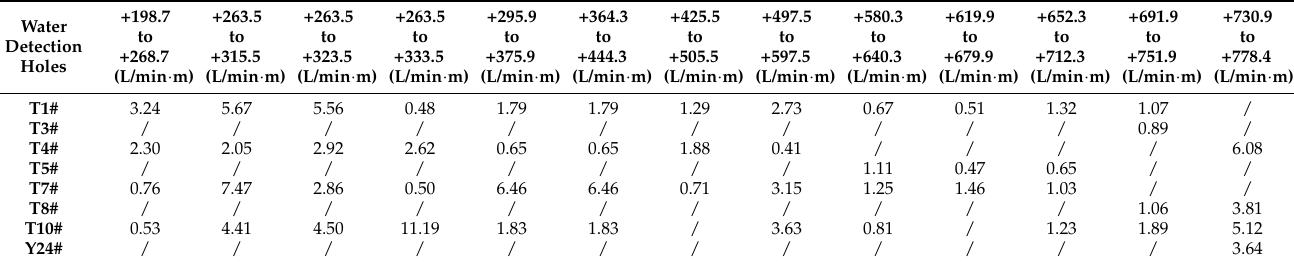
Table 23. Water output from different excavation sections